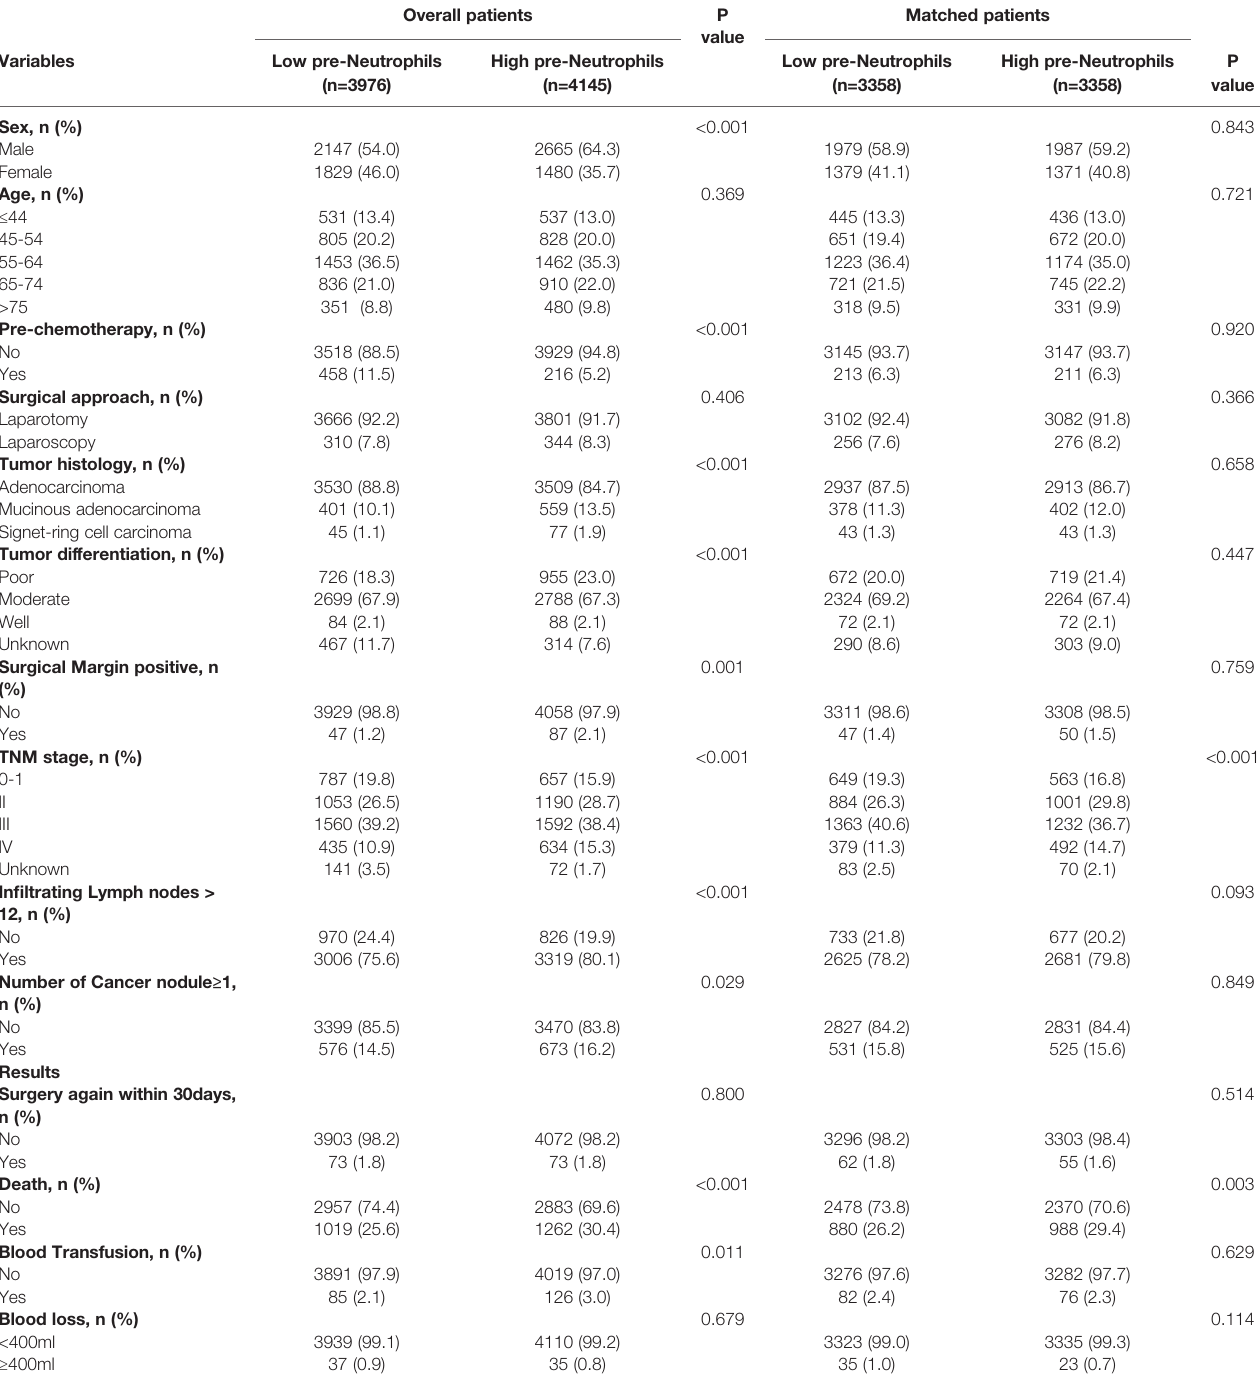
TABLE 6 | Patients ’ baseline characteristics in the total study cohort and the propensity-matched